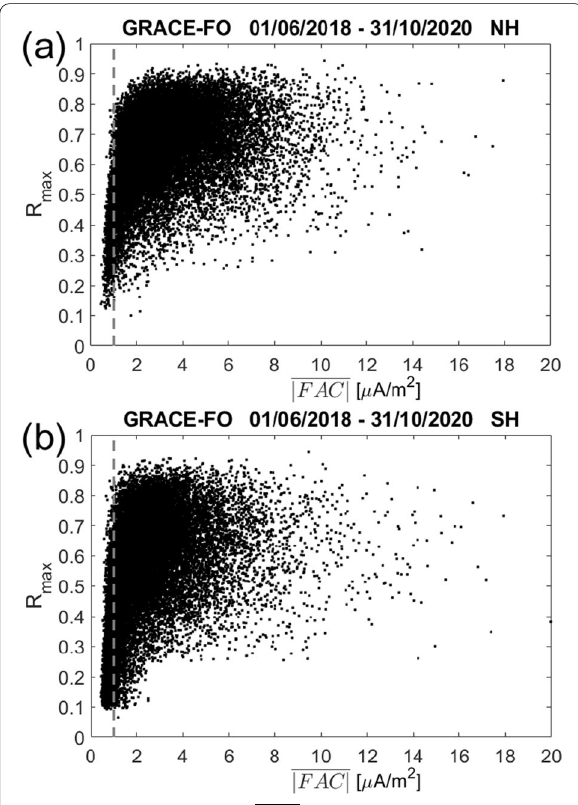
Fig. 4 Distribution of R max on | FAC | . The vertical dashed lines represent the applied threshold of 1 μA/m